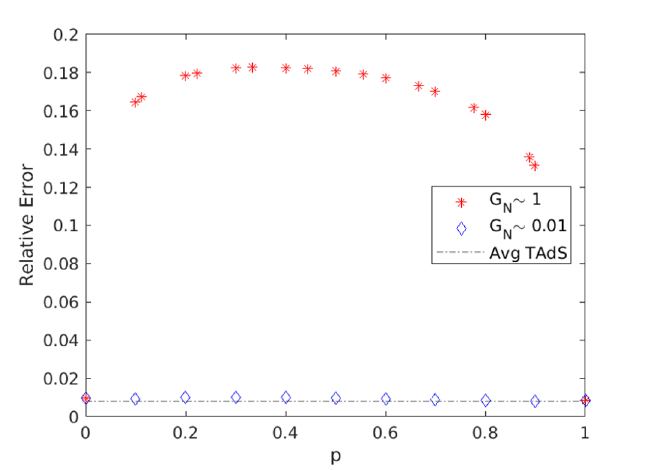
Figure 15. Boundary relative errors for superpositions of thermal AdS